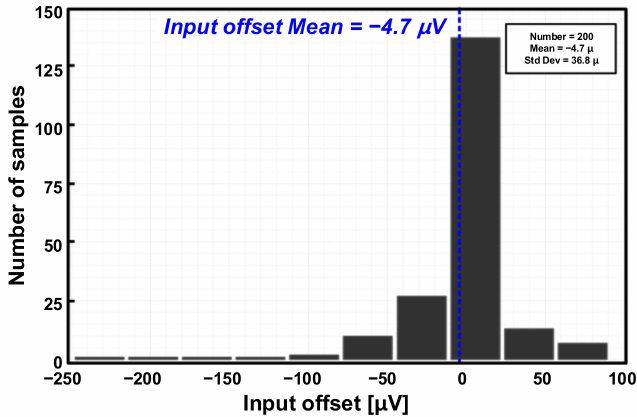
Figure 12. Monte Carlo simulation results of the input